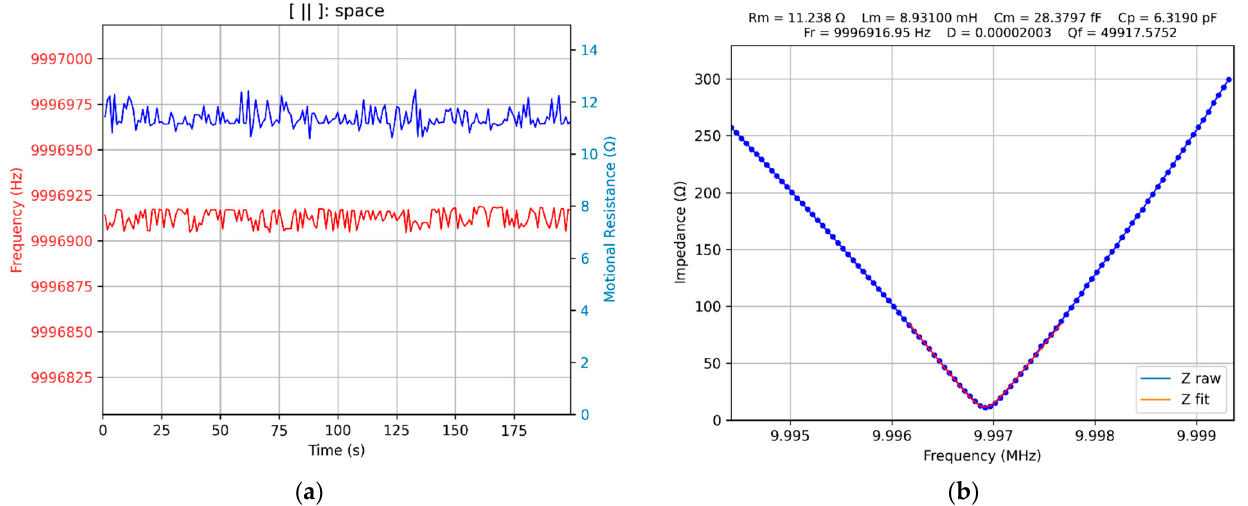
Figure 10. The virtual QCM: ( a ) series resonance ( F r ) and motional resistance ( R m ), ( b ) series resonant frequency tracking with 50 Hz constant steps in the VIA.